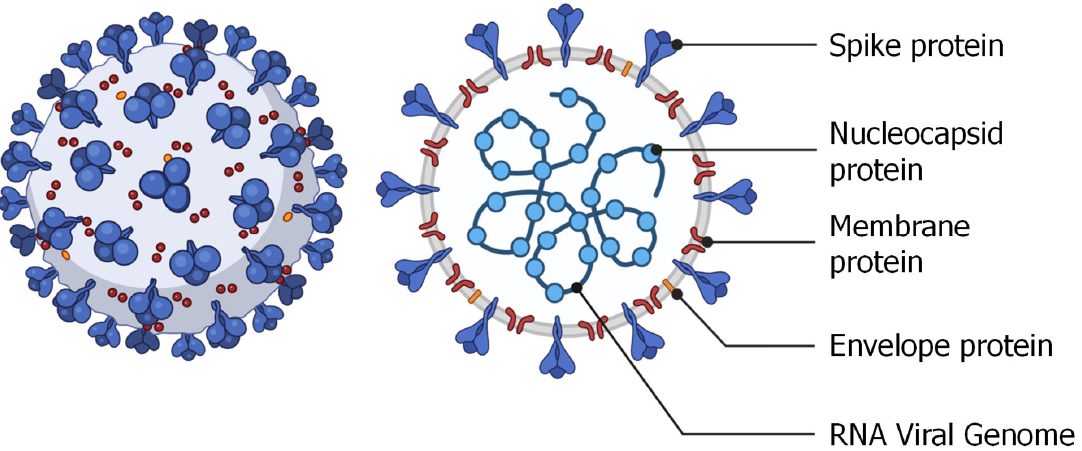
Figure 11. Schematic structure of SARS-CoV-2 virus. The genome of the virus represents a relatively large single-stranded positive-sense RNA formed the capsid with the nucleocapsid protein. This capsid is further packed by an envelope formed by three structural proteins: membrane protein, spike protein, and envelope protein. Redrawn from [10].